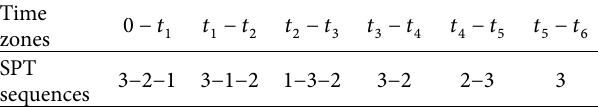
Figure 1: Order processing times with respect to one decision variable. Table 2: SPT sequences in different time